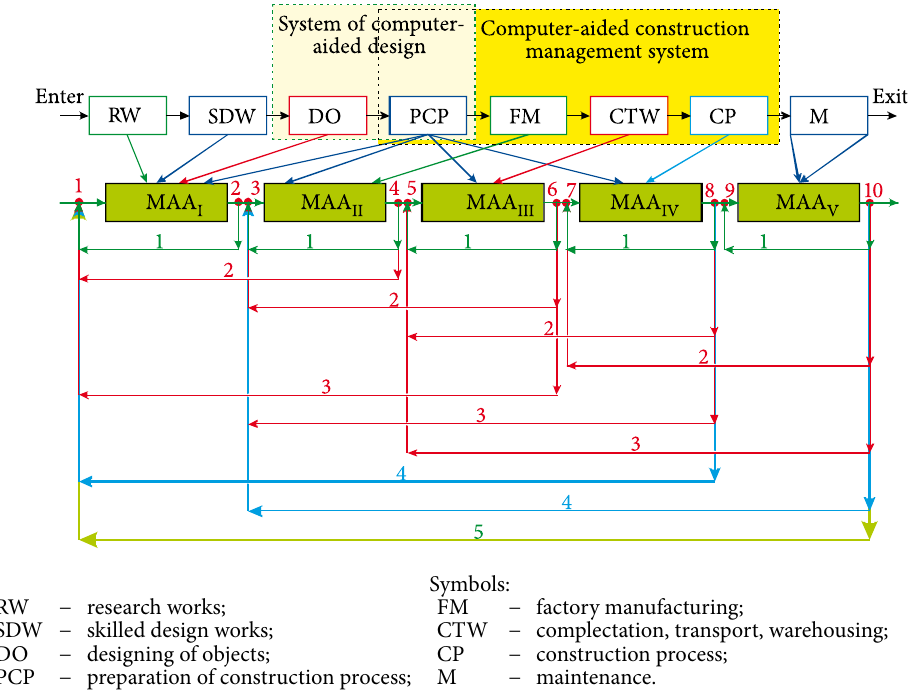
Fig. 3 . Decision-making assessment stages - local stages of МАА